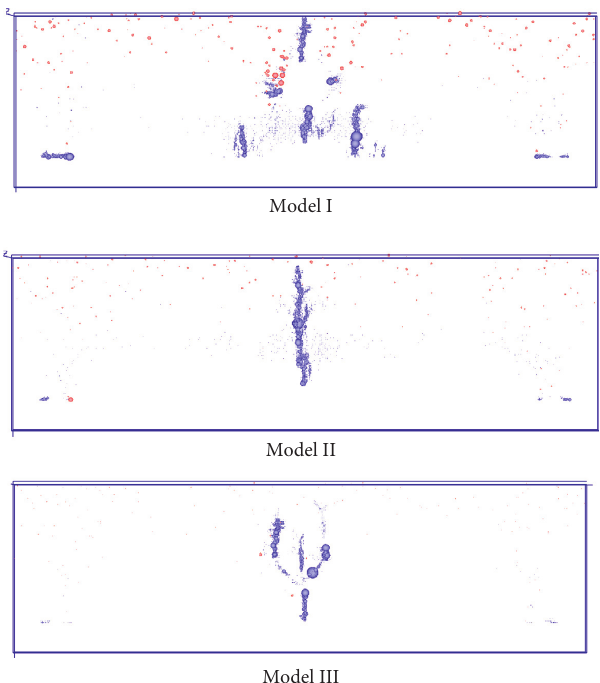
Figure 11: The distribution of AE under dynamic load.